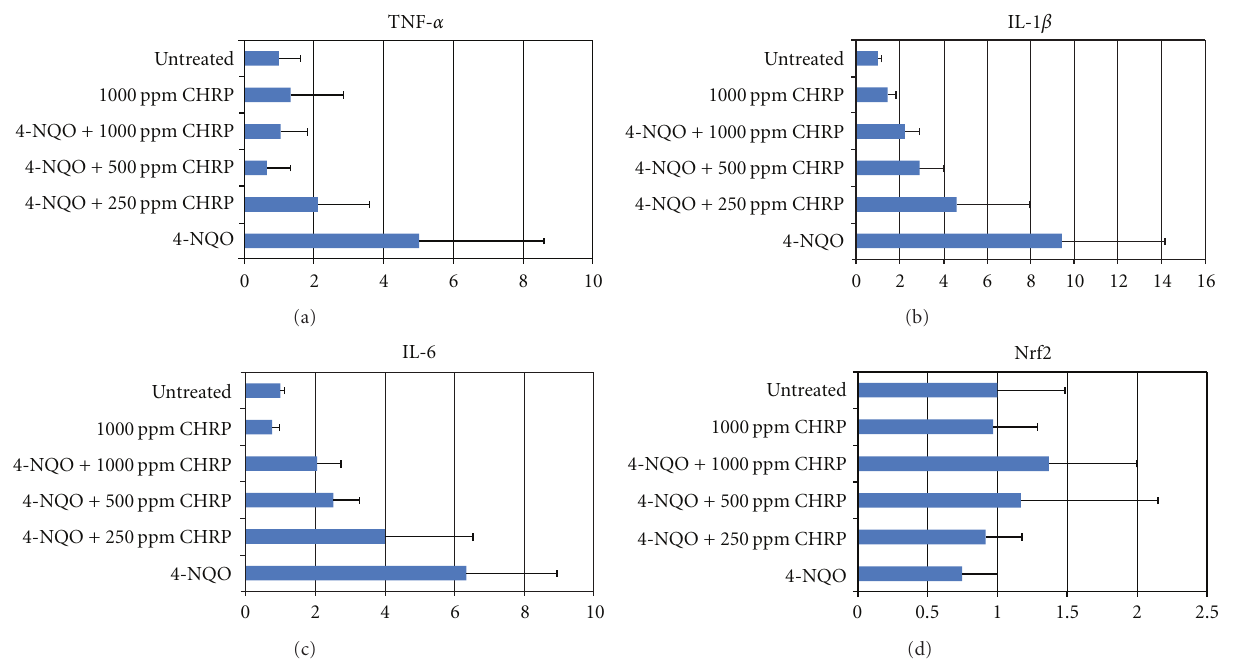
Figure 7: Dietary CHRP lowers mRNA expression of proinflammatory cytokines in the tongue of rats that received 4-NQO at week 8 of the